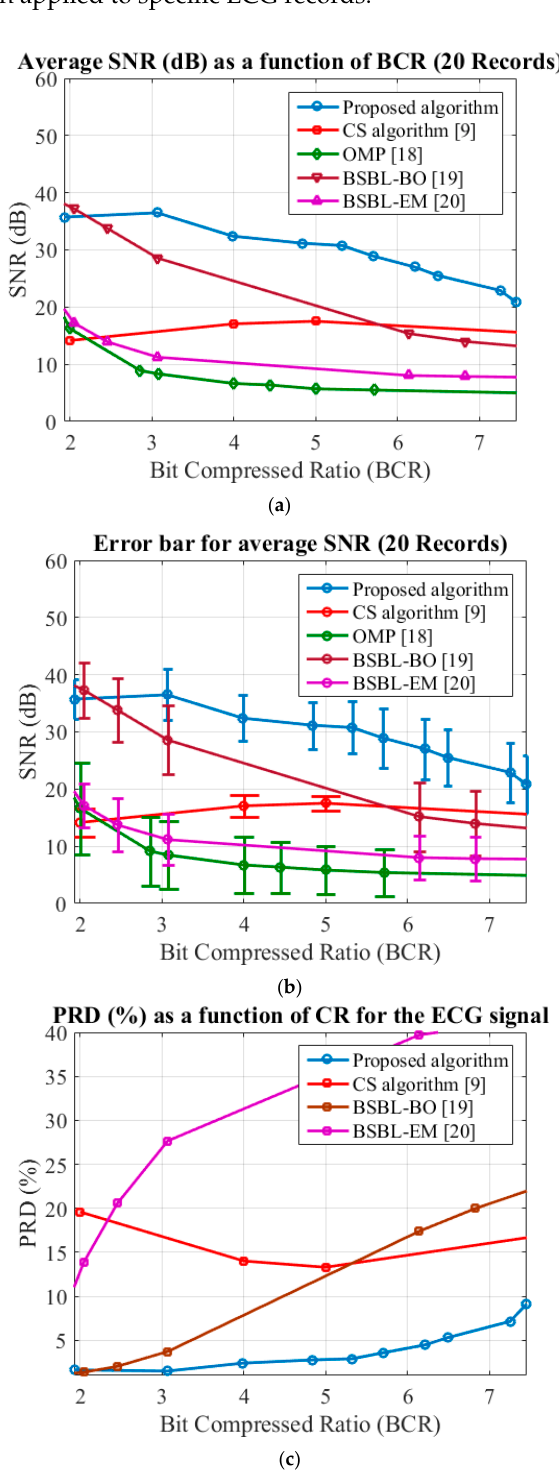
Figure 5. Comparison of various algorithms: ( a ) Signal-to-noise ratio (SNR); ( b ) Error bar for SNR (standard deviation); ( c ) Percent-root-different (PRD).